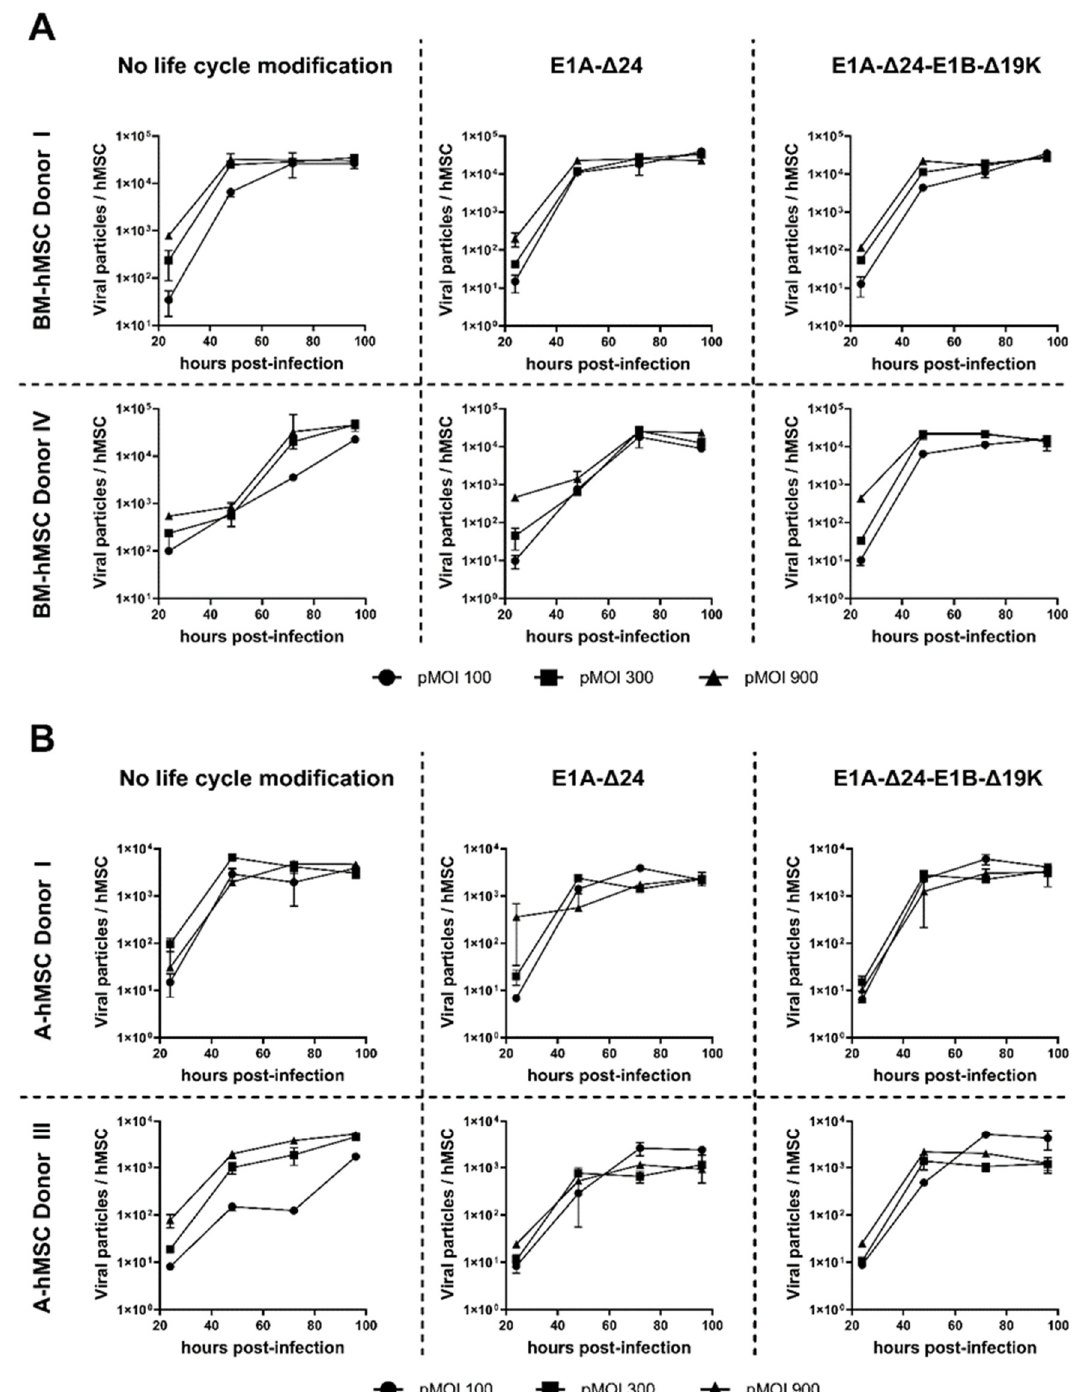
Figure 3. Replication of HAdV-5-HexPos3 in hMSCs is not affected by life cycle modifications. BM- ( A ) and A-hMSCs ( B ) were infected with the indicated replication-competent HAdV-5-HexPos3 vector at pMOI 100, 300, or 900. Every 24 h, cells and supernatant were harvested together to determine the amount of encapsidated adenoviral genomes by qPCR. Therefore, the harvested cells were disrupted in three freeze-thaw cycles and the lysate was treated with DNAse I to digest non-encapsidated viral genomes. Subsequently, samples were analyzed by qPCR to determine the number of adenoviral genomes using primers binding to the adenoviral E4 region. Results are shown as mean ± standard deviation of biological duplicates, each determined in technical triplicates.